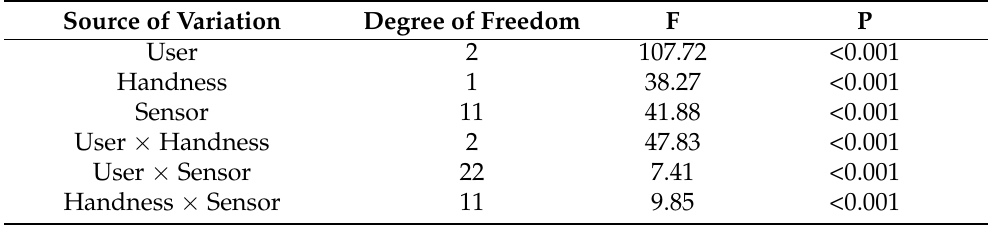
Table 7. Force results from three-way ANOVA on force data as a function of user, handness and sensor. Source of